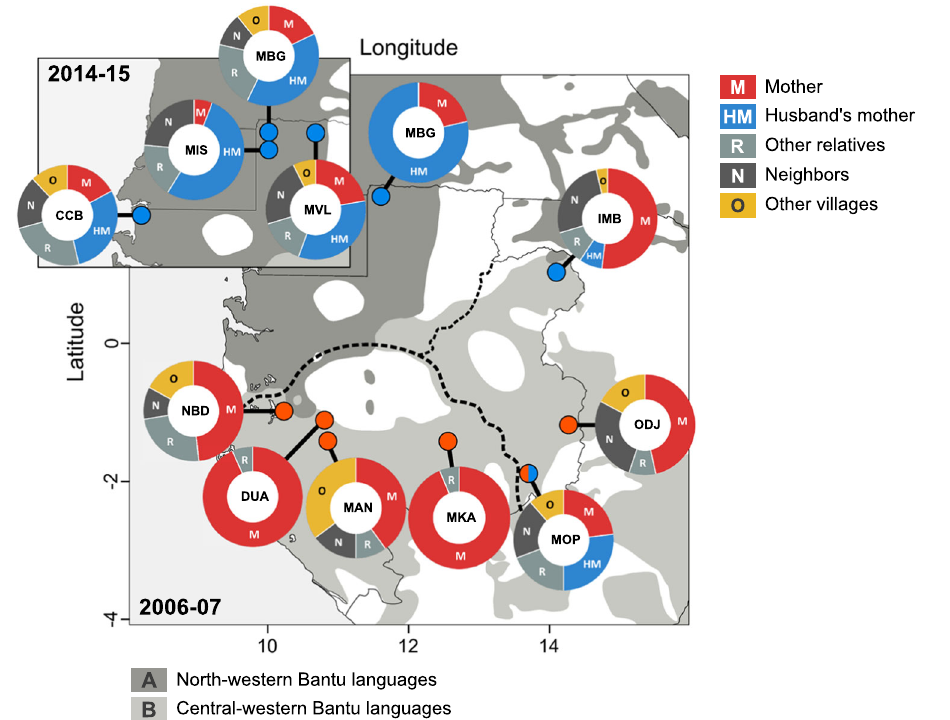
Fig. 1 Distribution of villages surveyed in Gabon in 2006 – 2007 and 2014 – 2015 (insert) and origin of cassava varieties in patrilineal and matrilineal villages (pie charts). ODJ was visited in 2004. MBG was visited in 2006 and 2015. Matrilineal and patrilineal villages are indicated by red and blue dots, respectively. The Ogooué River (dashed line) marks the demarcation between the patrilineal (north) and matrilineal (south) geographic domains, which corresponds also to the boundary between the A and B linguistic zones according to Guthrie ’ s classi fi cation of Bantu languages 68 . Vertical transmission (M: mother → daughter (red)) is predominant in matrilineal societies, while af fi nal transmission (HM: mother-in-law → daughter-in-law (blue)) is characteristic of patrilineal societies (see Table 1 and Supplementary Data 3 for details, including